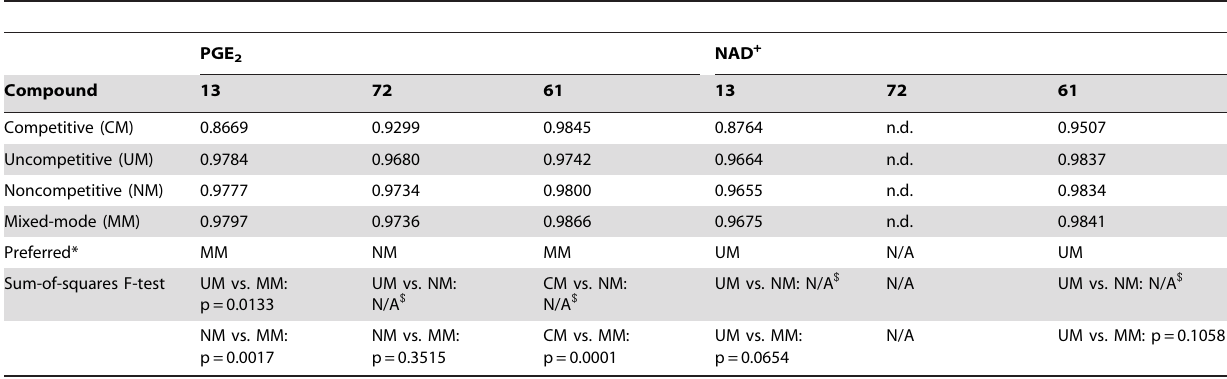
Table 2. Global fitting of substrate titration data to different modes of inhibition (CM, competitive inhibition; UM, uncompetitive inhibition; NM, noncompetitive inhibition; MM, mixed-mode inhibition).